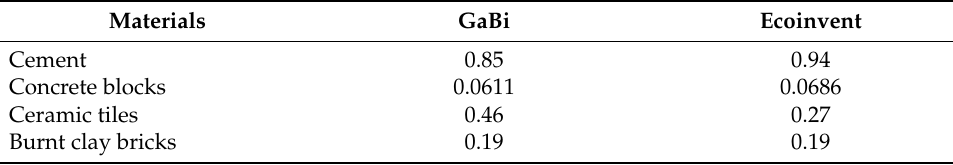
Table 6. CEC in kg CO 2 e/kg for GaBi and ecoinvent database.